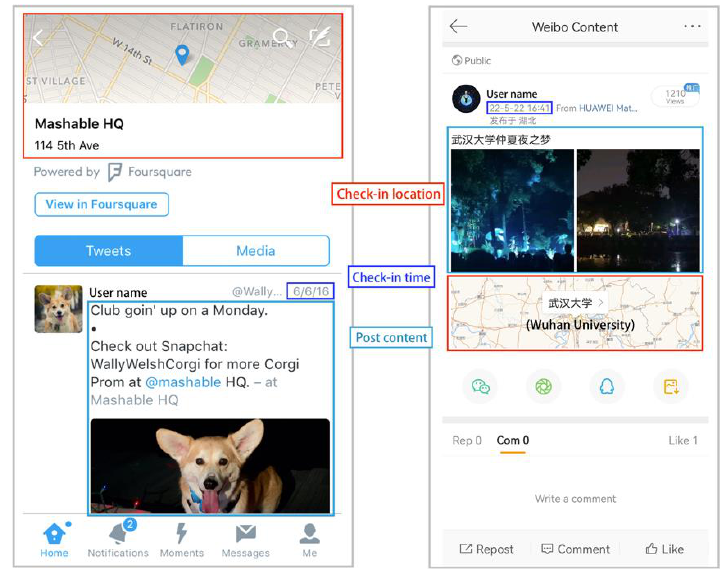
Figure 3. An example of geo-tagged Tweets and Weibo check-ins.